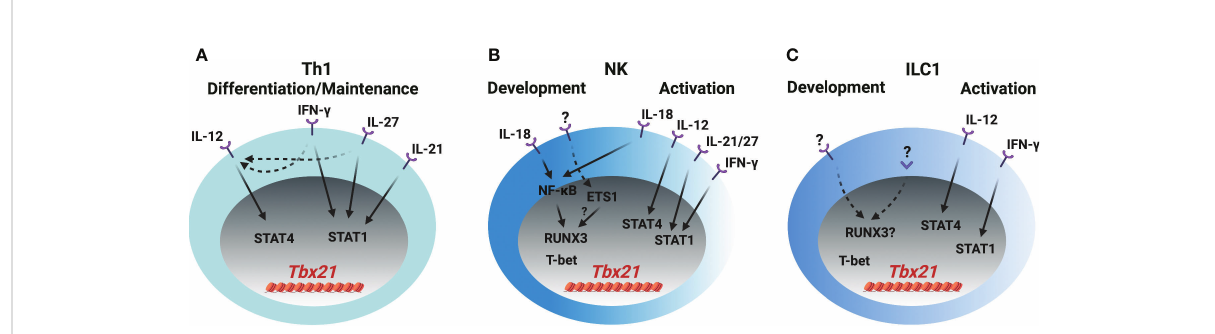
FIGURE 2 T-bet induction in Th1 cells, NK cells and ILC1s (A) IL-12/STAT4, IFN- g /STAT1, IL-21/STAT1 and IL-27/STAT1 signaling induce T-bet expression through Tbx21-CNS-12 during Th1 cell differentiation and maintenance. IFN- g and IL-27 also upregulate IL-12R expression in T cells. (B) IL-18/ NF- k B signaling induces RUNX3 expression and plays a role in the initial T-bet induction through Tbx21-CNS-3 during NK cell development. ETS1 is critical for the T-bet expression in NKPs, pro-NK cells and mature NK cells. Whether ETS1 directly regulates T-bet induction or indirectly regulates T-bet induction through RUNX3 is not clear. T-bet may self-regulate its expression during NK cell development. IL-18/NF- k B/RUNX3 regulates T-bet expression through Tbx21-CNS-3 , and IL-12/STAT4, IFN- g /STAT1, IL-21/STAT1 and IL-27/STAT1 regulate T-bet expression through Tbx21-CNS-12 during NK cell activation. (C) The mechanism of T-bet induction during ILC1 development is not clear. IL-12/STAT4 and IFN- g /STAT1 may regulate T-bet expression during ILC1 activation. Only a small proportion of ILC1s express